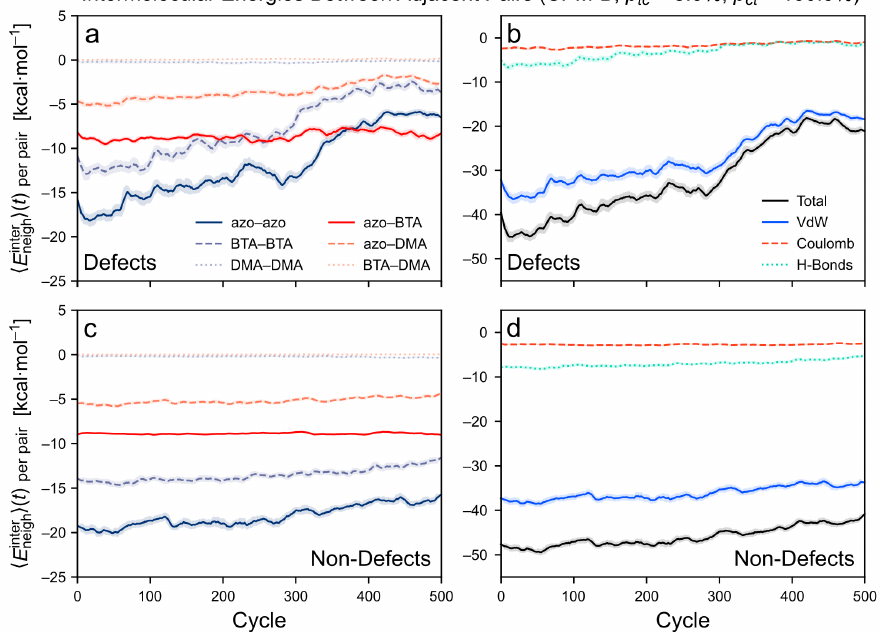
Figure 11. Intermolecular energies between adjacent monomer pairs in the TrisAzo stack as a function of time. The CPM-B simulation with p tc = 5.0% is shown. The energy contributions are averaged for ( a , b ) all neighboring monomer pairs with defects, and ( c , d ) without defects. Left-hand side: energy decomposition by interactions between the different physical parts of the TrisAzo molecules. Right- hand side: energy decomposition by types of non-covalent interactions. Each curve is smoothed via a running average (window size of 20 cycles, corresponding to 0.96ns). Shaded error bands indicate the standard deviation of the raw curve in each